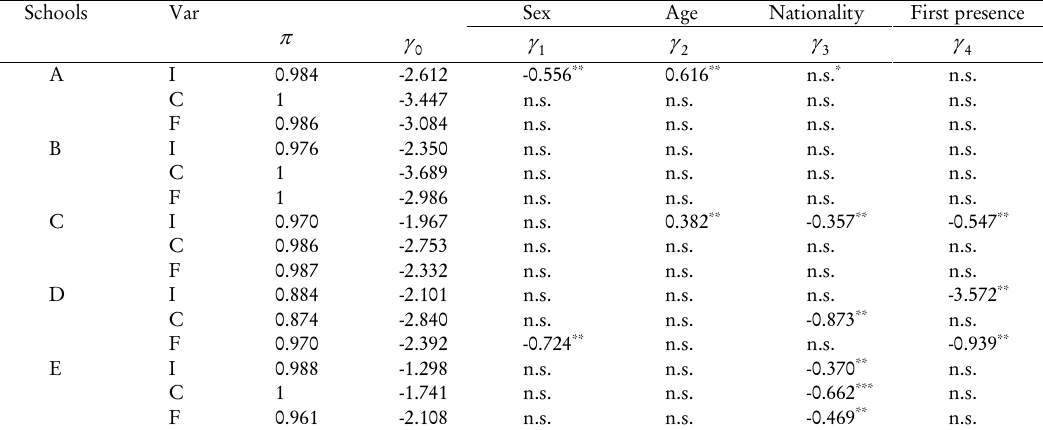
ξ and π parameters for subgroups of subjects that behave differently in terms of feeling toward the ski school